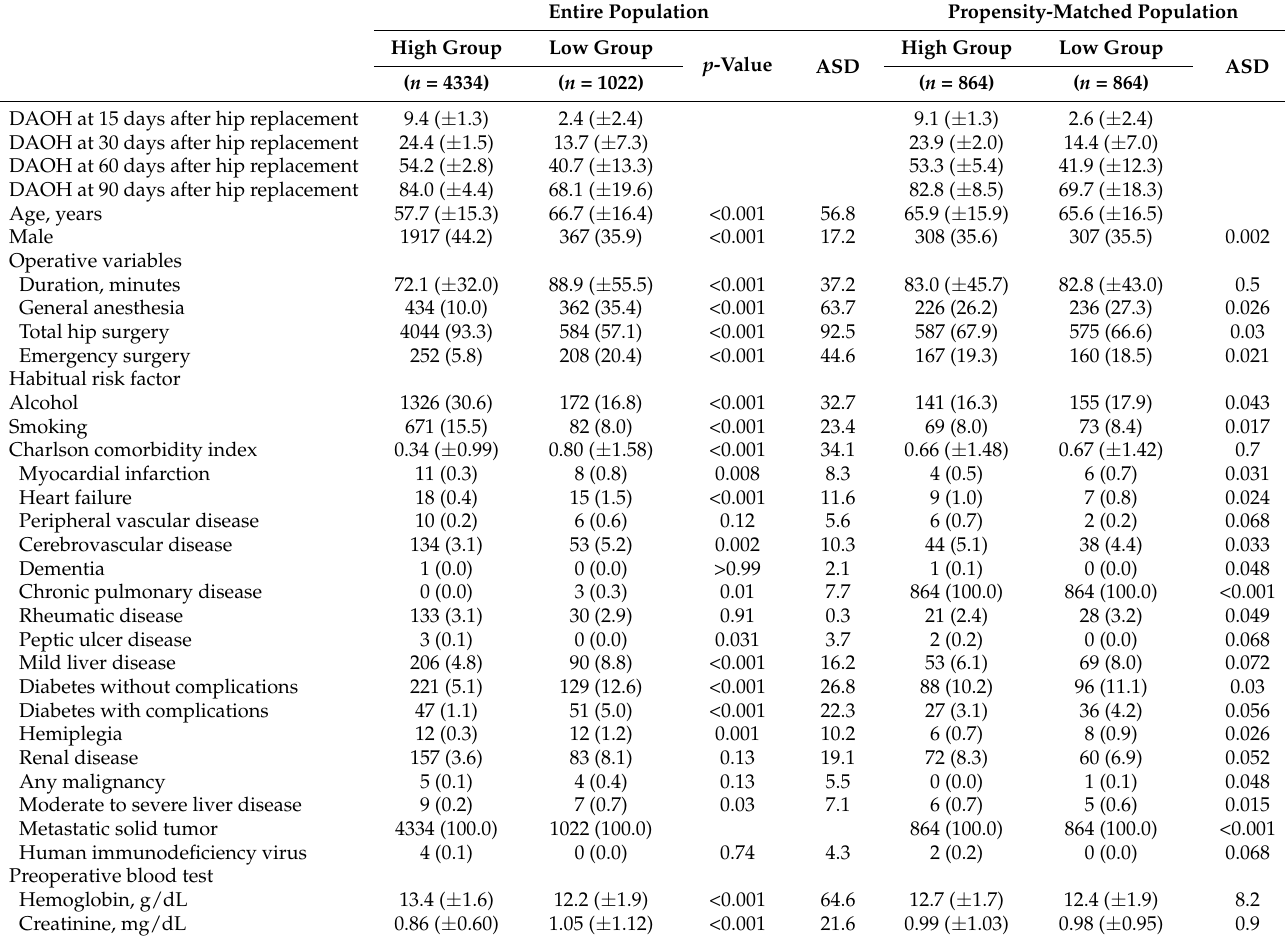
Table 2. Baseline characteristics according to days alive and out of hospital (DAOH).